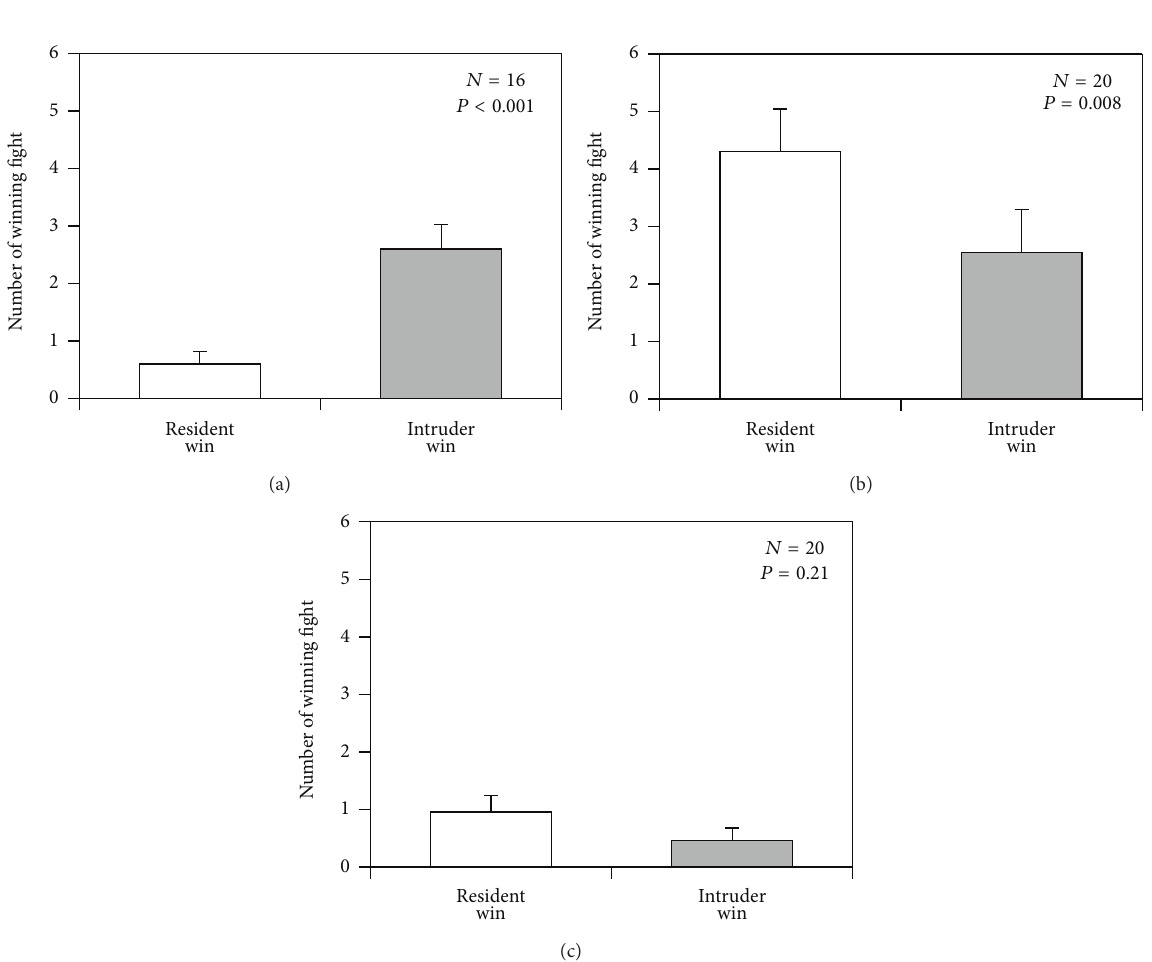
Figure 2: The times individuals took in winning fights in the prior experienced contest (experiment 2). (a) A larger intruder was introduced. (b) A similar-sized intruder was introduced. The data are means ± SE.